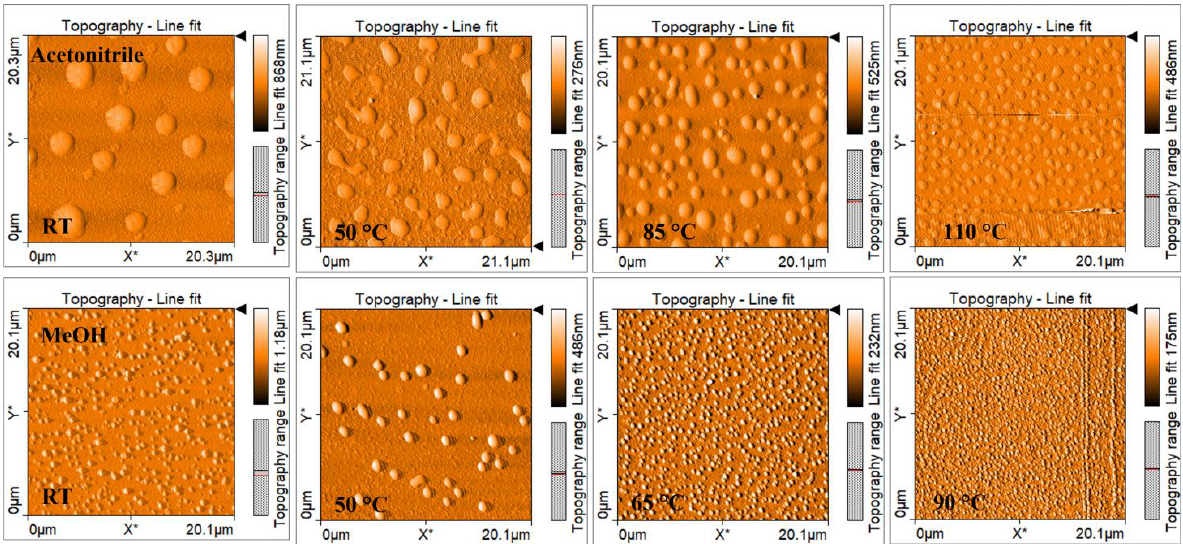
Figure 3. Representative AFM image for aggregates formed from acetonitrile and MeOH solutions.